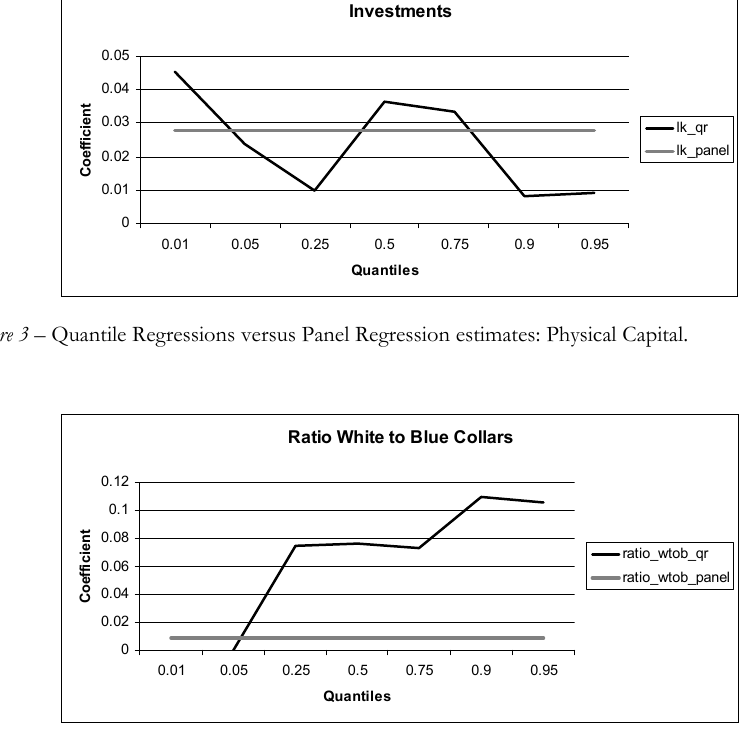
Figure 4 – Quantile Regressions versus Panel Regression estimates: Human Capital.